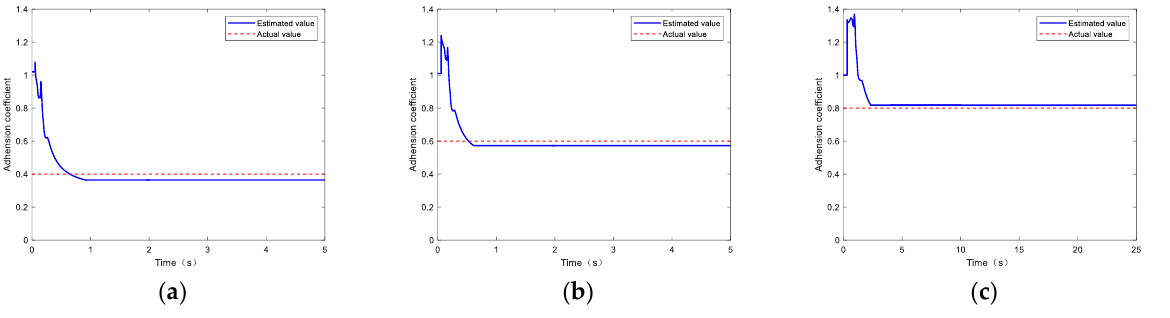
Figure 10. Tire-road friction coefficient estimation results. ( a ) Estimation results for μ = 0.4; ( b ) estimation results for µ = 0.6; ( c ) estimation results for µ = 0.8. Table 5. Tire-road friction coefficient estimation results.